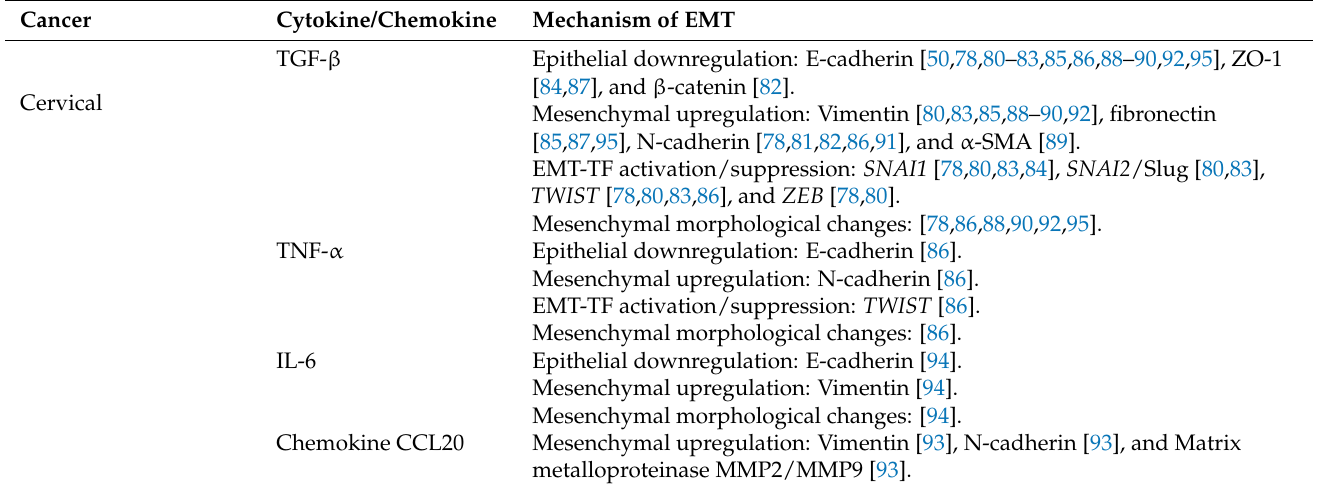
Table 3. EMT changes associated with cytokines/chemokines in cervical